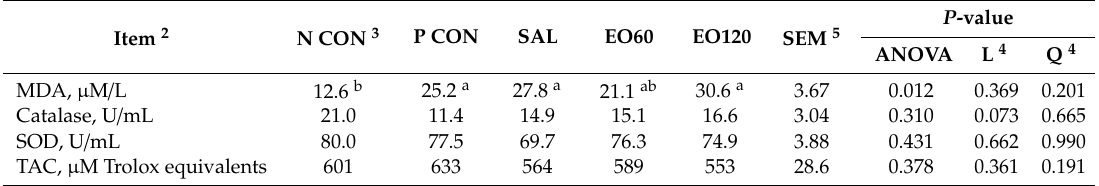
Table 8. E ff ect of supplementation of encapsulated essential oils on serum antioxidant parameters in coccidiosis-vaccine-challenged broiler chickens